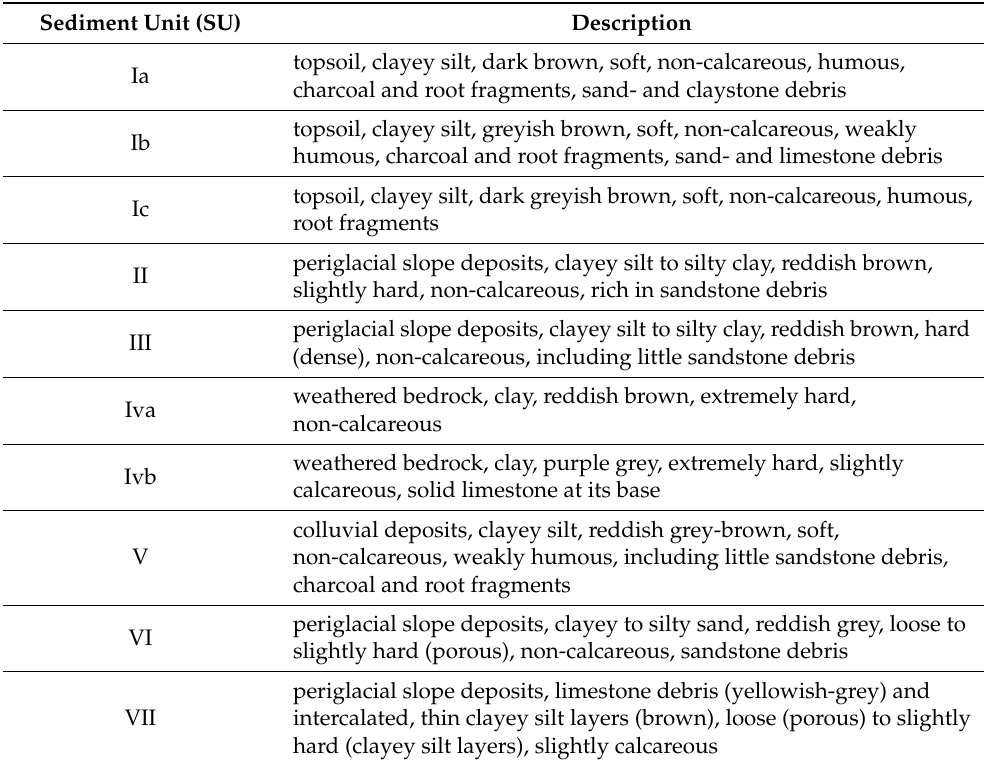
Table 3. Sediment units described for the Biersdorf sediment